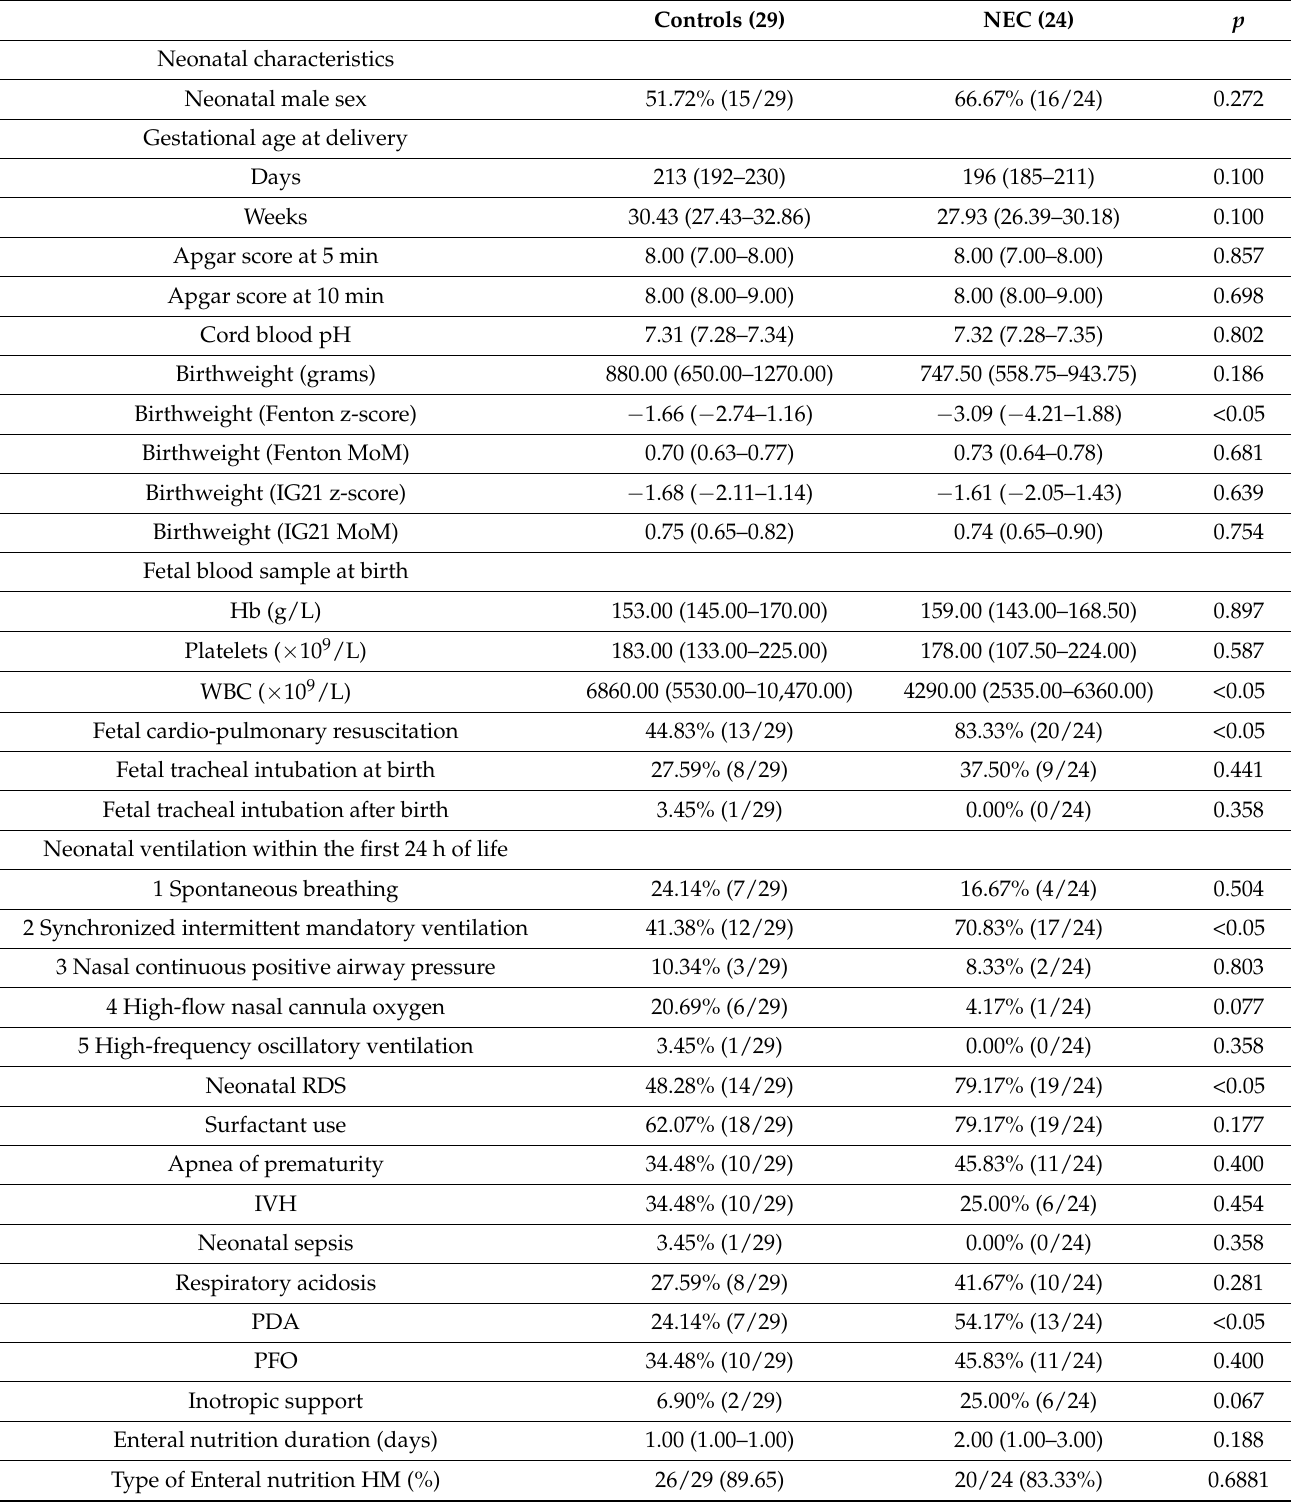
Table 2. Neonatal